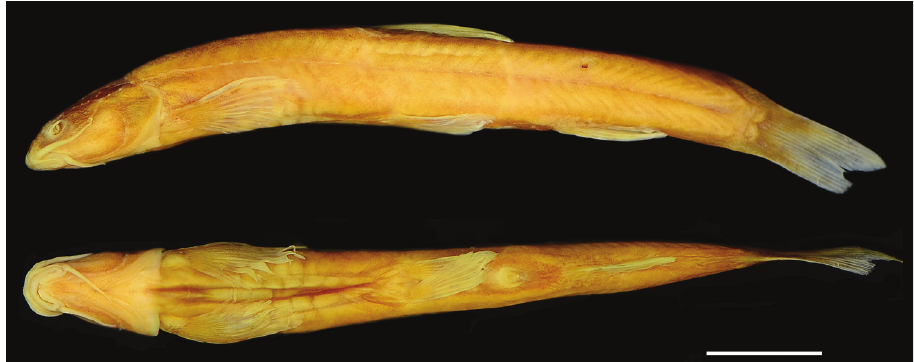
Figure 1. Lateral and ventral views of Triplophysa anshuiensis sp. n., holotype KIZ 2012005747, 65.2 mm SL. Scale = 1 cm.